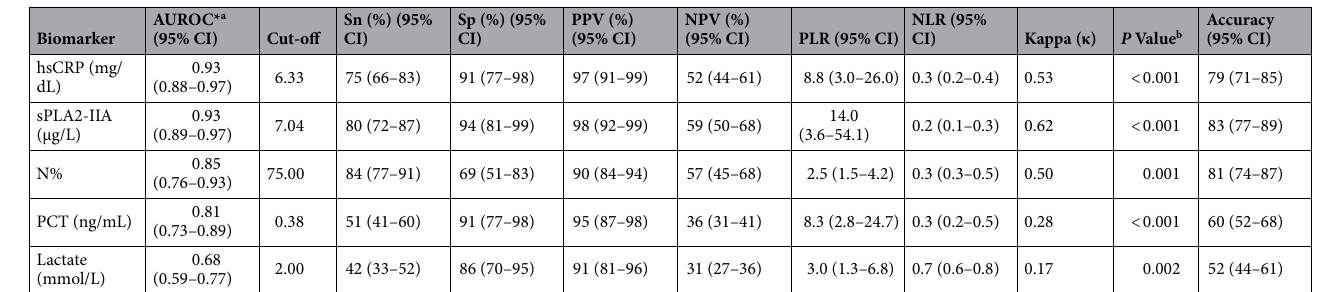
Table 3. The ability of five tested biomarkers to differentiate bacterial infection in ED. AUROC area under receiver operating characteristic curve, Sn sensitivity, Sp specificity, PPV positive predictive value, NPV negative predictive value, PLR positive likelihood ratio, NPR negative likelihood ratio, hsCRP high-sensitive C-reactive protein, sPLA2-IIA secretory phospholipase 2-IIA, %, neutrophil percentage, PCT procalcitonin. The result compared the bacterial infection group (n = 116) against non-bacterial infection group (n = 35). *AUROC classification: 0.70–0.79 = Fair, 0.80–0.89 = Good, > 0.90 = Excellence . a Patients recruited excluding missing data(biomarkers) patients; complete case analysis. b P values are based on χ 2 test, P < 0.05 indicates a significant